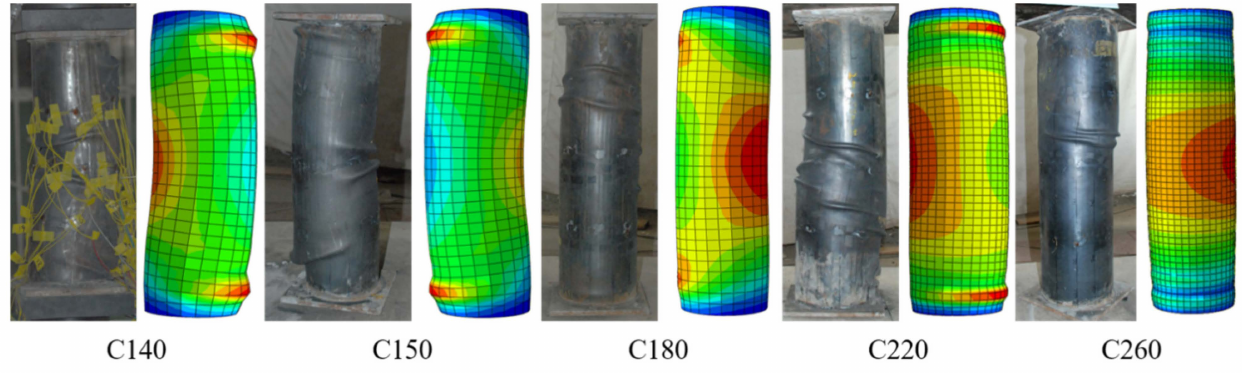
Figure 9. Failure modes of CFHST stub